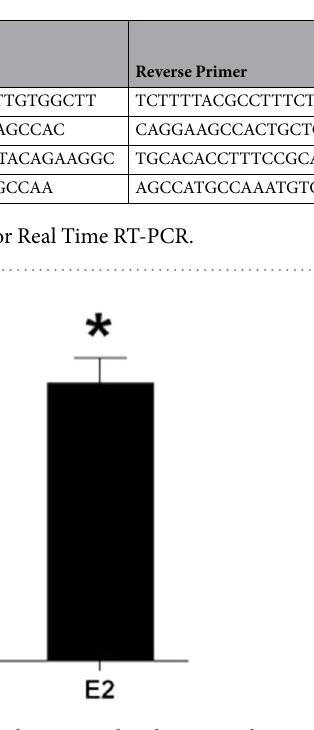
Figure 1. Serum estradiol levels in control and E2 treated rats. Adult female Sprague Dawley rats were either sham-implanted or implanted with slow release estradiol 17- β (E2) pellets for 90 days. Estradiol levels were measured by RIA in serum collected from trunk blood at the time of sacrifice at the end of 90 day exposure. * Indicates p <